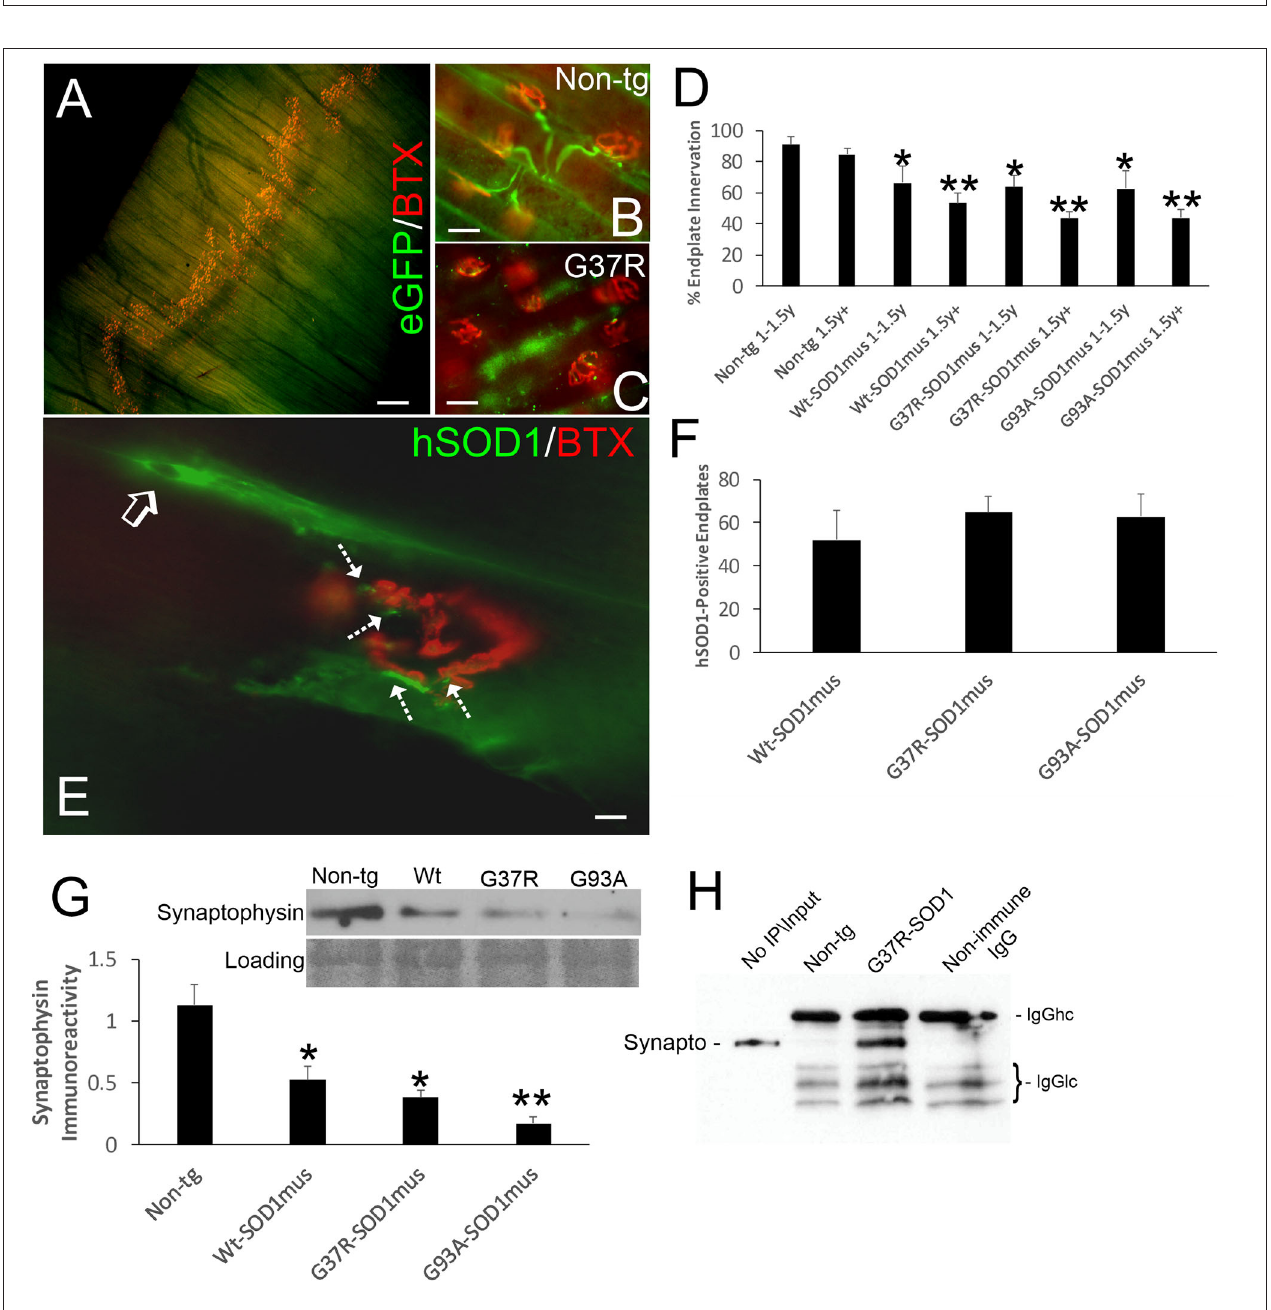
FIGURE 5 | Structural and molecular pathology occur at the NMJ in skeletal muscle of hSOD1 mus mice. (A) Whole mount of a mouse diaphragm showing the distribution pattern of NMJ/motor endplates (red, α -bungarotoxin, BTX). Scale bar = 18 µ m. (B) Motor endplate (red, BTX) innervation by ventral horn motor neuron axons (green, Hb9-egfp) in non-tg mouse diaphragm. Scale bar = 30 µ m. (C) Motor endplate denervation and axonopathy (swollen dystrophic axons, green) in hSOD1 mus mouse diaphragm. Scale bar = 30 µ m. (D) Graph showing the age-related loss of diaphragm motor endplate innervation (mean ± SD, * p < 0.05; ** p < 0.01). (E) hSOD1 aggregates (arrows, green) near motor endplates. (F) About 50% of motor endplates are associated with hSOD1 aggregates by midlife in hSOD1 mus mouse diaphragm. Scale bar = 9 µ m. (G) Western blotting revealed a loss of presynaptic terminal synaptophysin in hSOD1 mus mouse diaphragm. Ponceau S stained membrane shows protein loading. (H) Immunoprecipitation of synaptophysin in diaphragm extract followed by western blotting for 3-nitrotyrosine shows increased nitration of synaptophysin in hSOD1 mus mouse but comparatively sparse in age-matched non-tg mice.